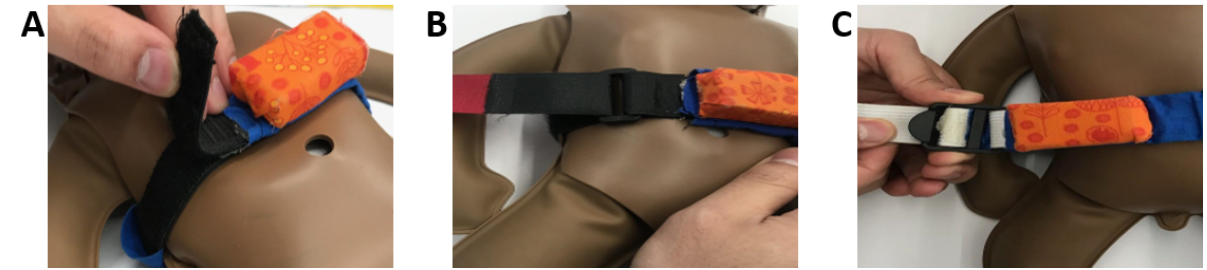
Figure 6. NeMo band embodiments: (A) velcro; (B) velcro-with-loop; (C) adjustable